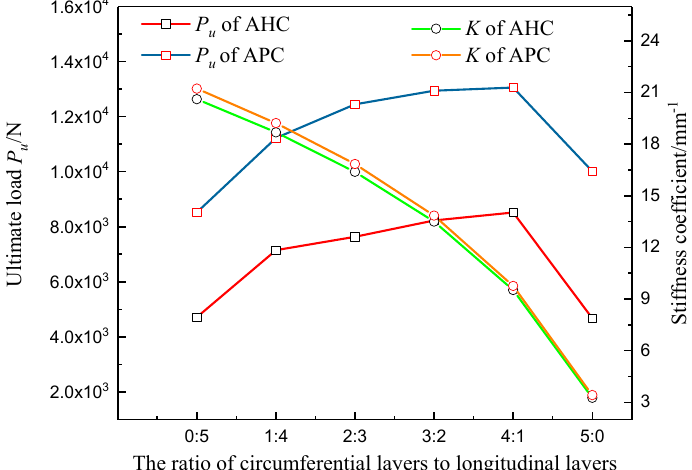
Figure 19. Curves of ultimate load P u and stiffness coefficient K changing with the ratio of circumferential layers to longitudinal layers.